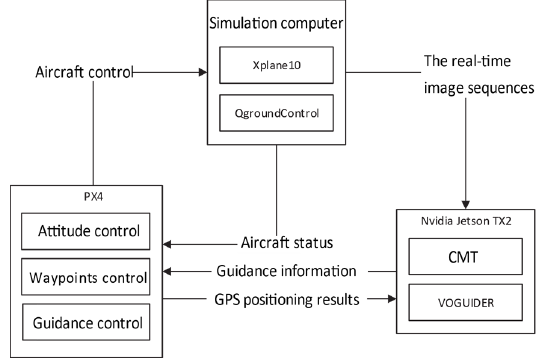
Figure 2. Block diagram of the simulation system.